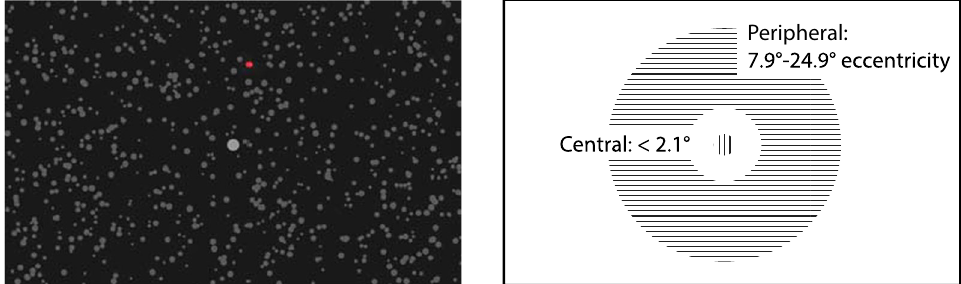
Fig. 2 The Sustained Attention to Response Task (SART). Subjects fixated at a center point and a field of random dots rotated around the center. At random intervals, a red/green dot would appear either in the central region or the peripheral